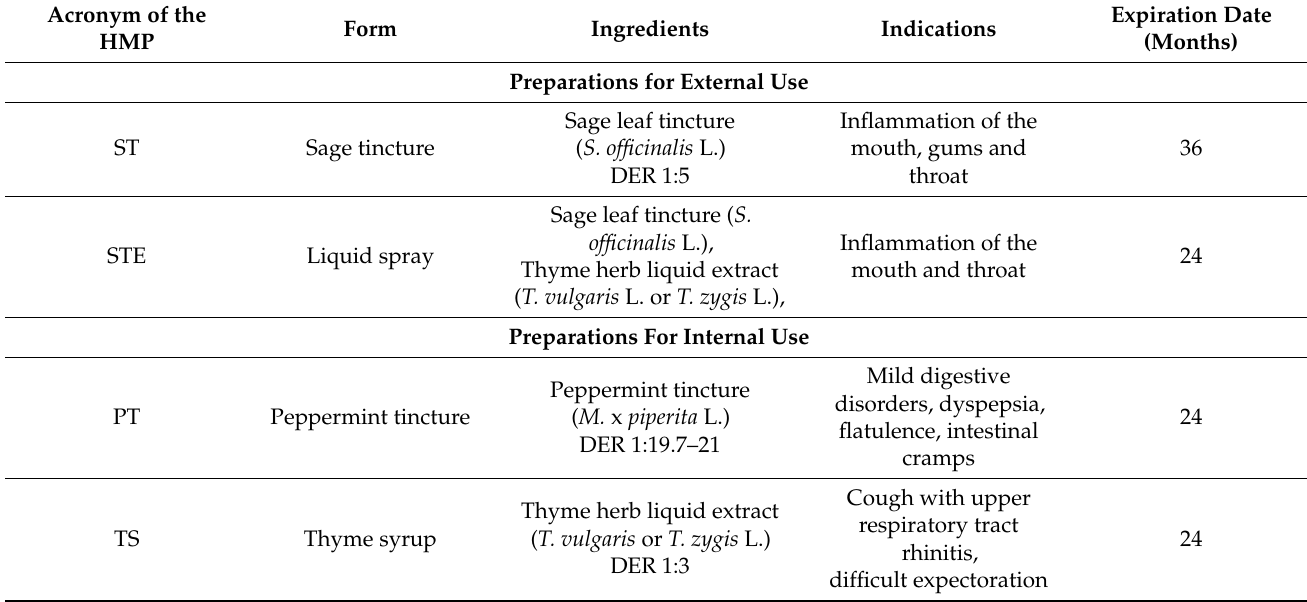
Table 1. Basic data on the analyzed herbal medicinal